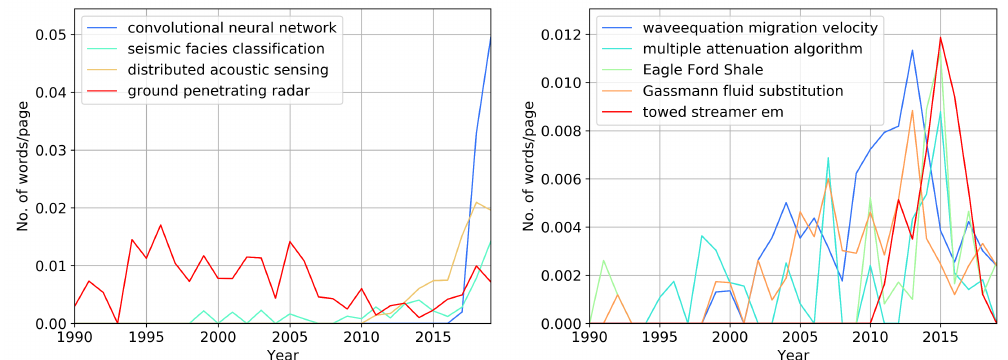
Figure 13. Trigrams that show the highest rate of growth in occurrence ( left ) and decline ( right ) in the past four